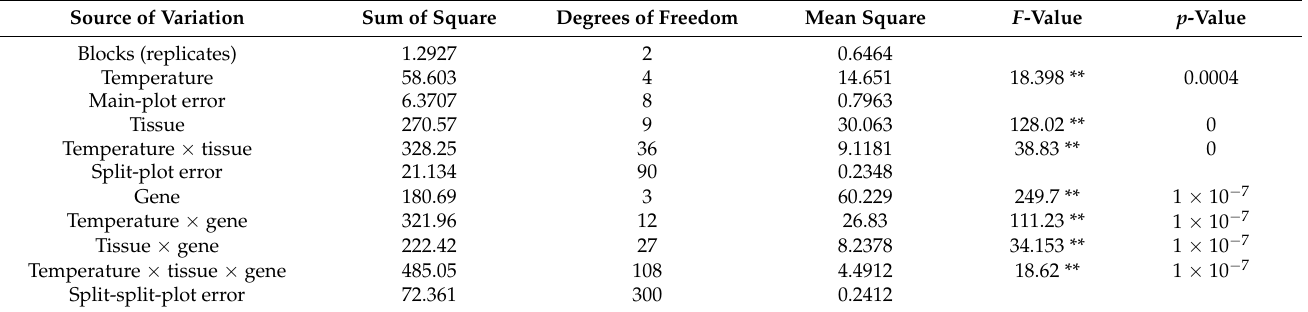
Table 1. SSP analysis of variance for S. maximus high temperature experiment with four PPAR genes, five temperature gradients, and ten tissues.